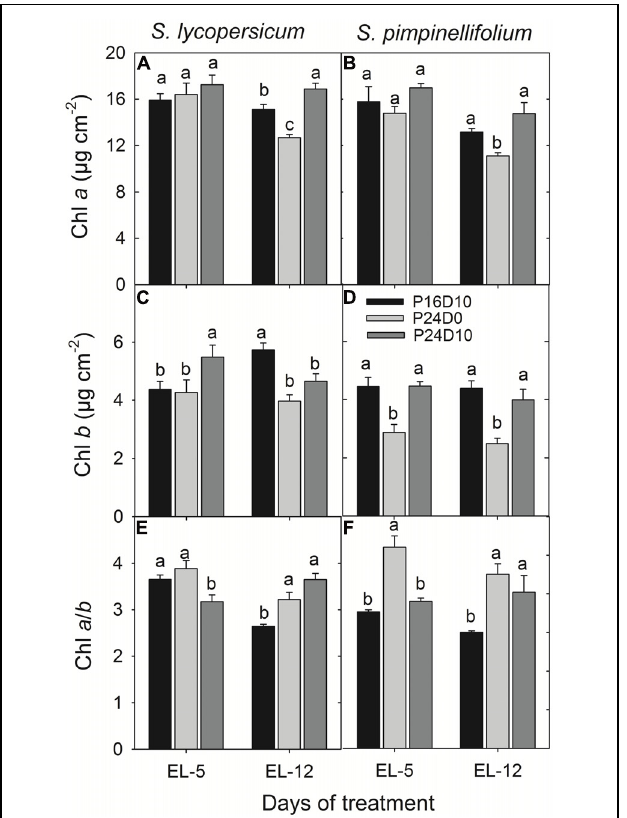
FIGURE 3 | Chl a , Chl b and Chl a / b ratio of S. lycopersicum (A,C,E) and S. pimpinellifolium (B,D,F) at different days under P16D10, P24D0, and P24D10 growth conditions. The pigment data was taken at the end of the light period (EL, 12:30 CEST) of each day. Vertical bars are SEM ( n = 4). Treatment means with different letters within each day are significantly different and the statistical analysis was done by the Tukey and Waller–Duncan k-ratio t